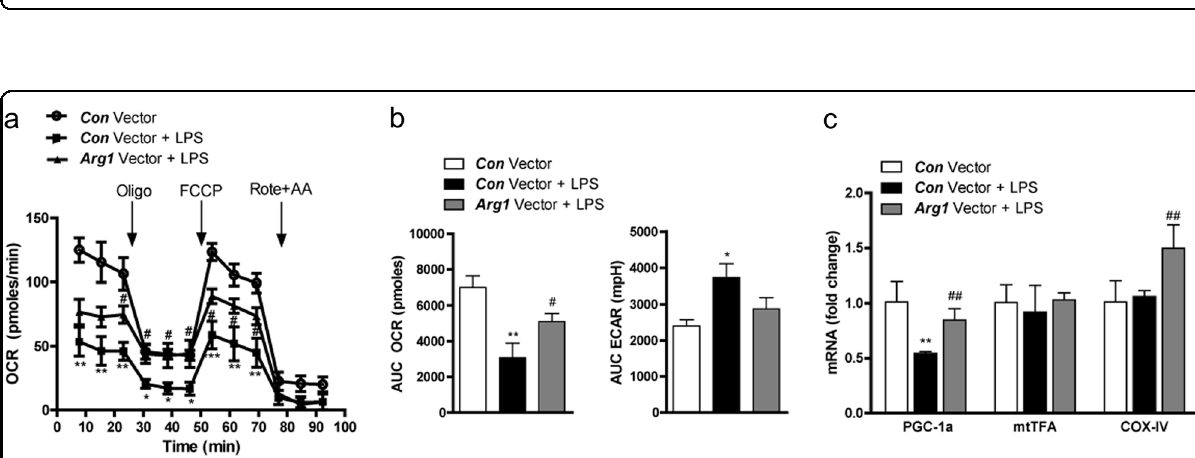
Fig. 6 The overexpression of Arg1 enhanced mitochondrial function in TECs. a Real-time OCR rates were measured using an XF24 extracellular fl ux analyzer. b Basal OCRs and ECARs. c Relative mRNA levels of mitochondrial biogenesis markers. Data represent the means ± SEMs ( n = 5). * P < 0.05 and ** P < 0.01 versus Con vector-treated RAW264.7 cells without LPS treatment; # P < 0.05 and ## P < 0.01 versus Con vector-treated RAW264.7